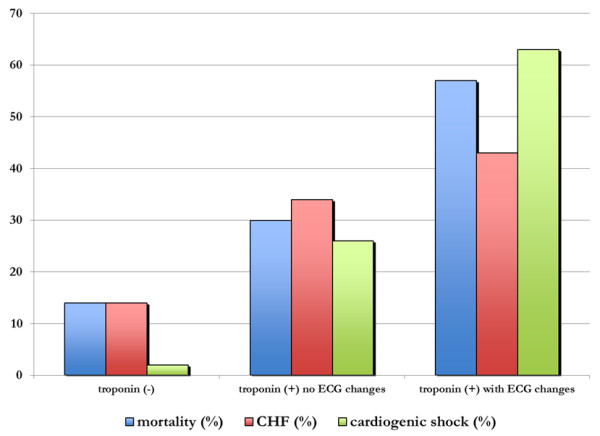
Cardiac events and mortality stratified by post-operative cTnI status and ECG changes. Groups differed significantly for mortality (P < 0.001), CHF (P = 0.004) and cardiogenic shock (P < 0.001).